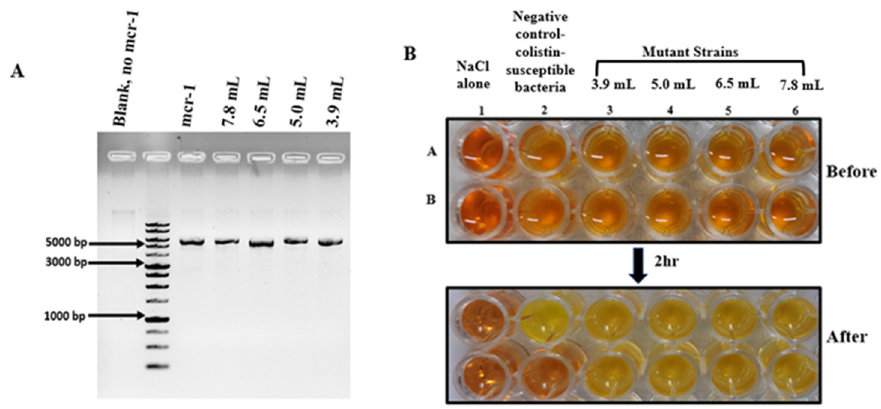
Figure 2. ( A ) Agarose gel image showing the presence of the MCR-1 plasmid in resistant strains (~5081 bp) ( B ) Rapid polymyxin NP test based identification of colistin sensitive and resistant strains.